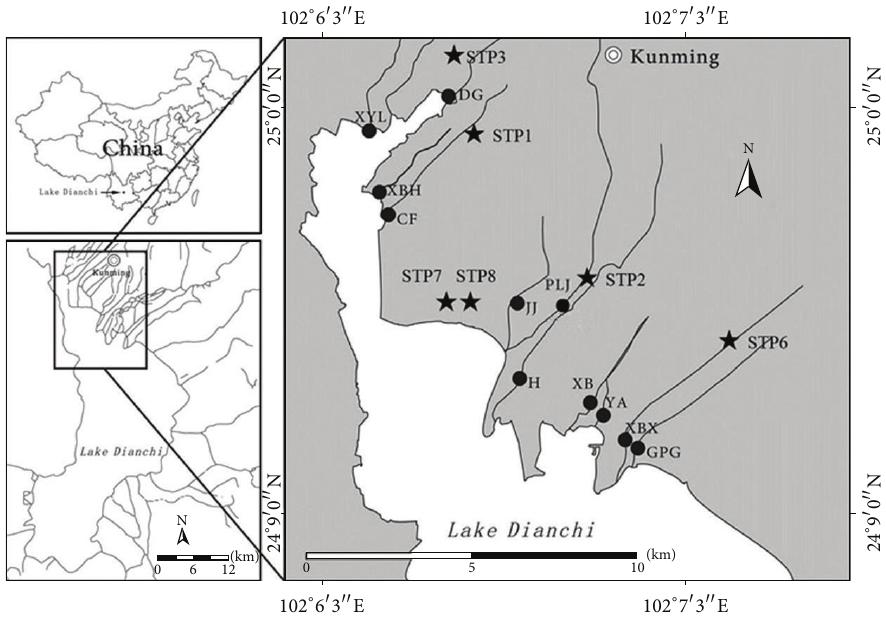
Figure 1: Sampling sites in rivers of Dianchi Lake. Black dot ( e ) is sampling site, and Pentagram ( 󳀅 ) is sewage treatment plants (STP).